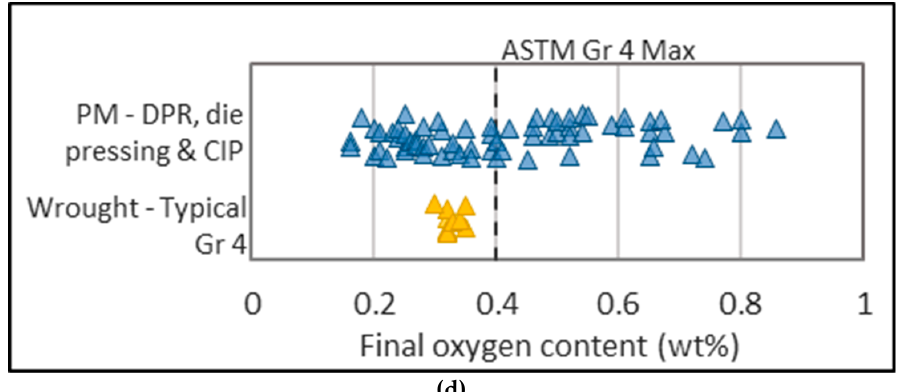
Figure 4. Final oxygen content for titanium powder metallurgy (PM) compacts versus typical oxygen content for wrought product specified to ASTM grades 1–4 ( a–d ).